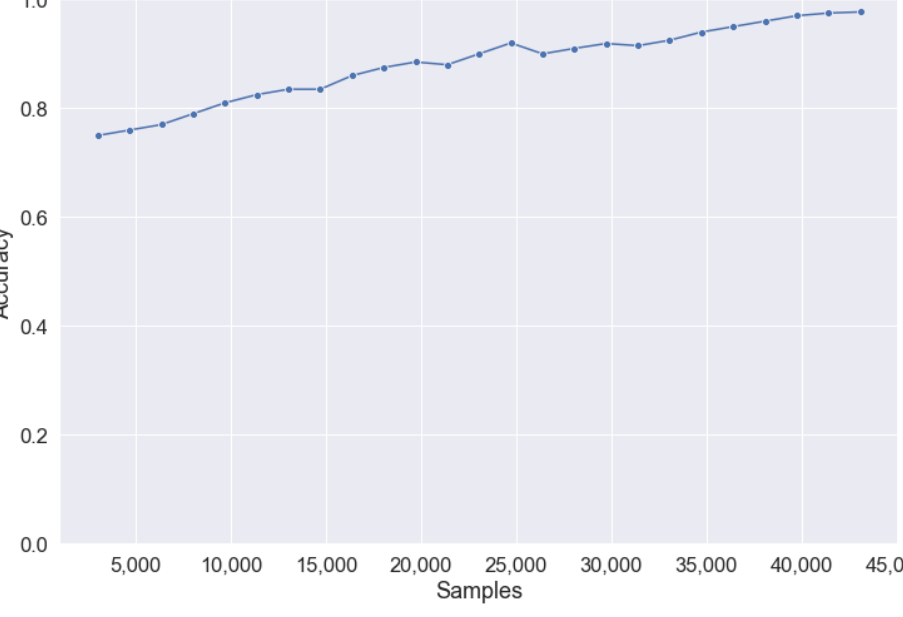
Figure 13. Learning curve of the